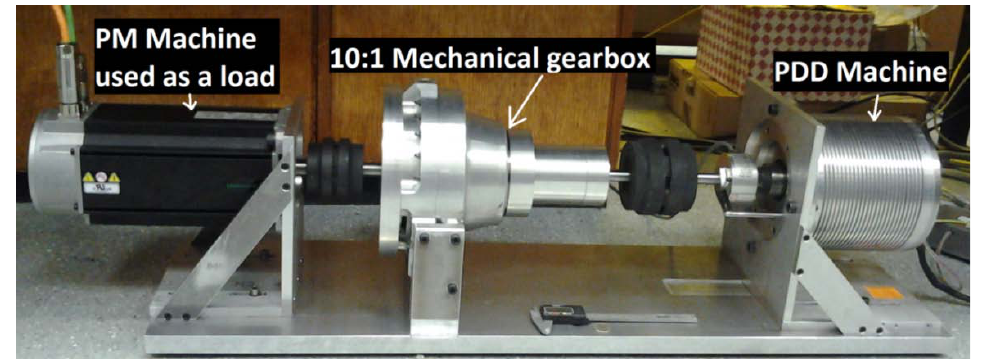
Figure 13. The Pseudo Direct Drive test